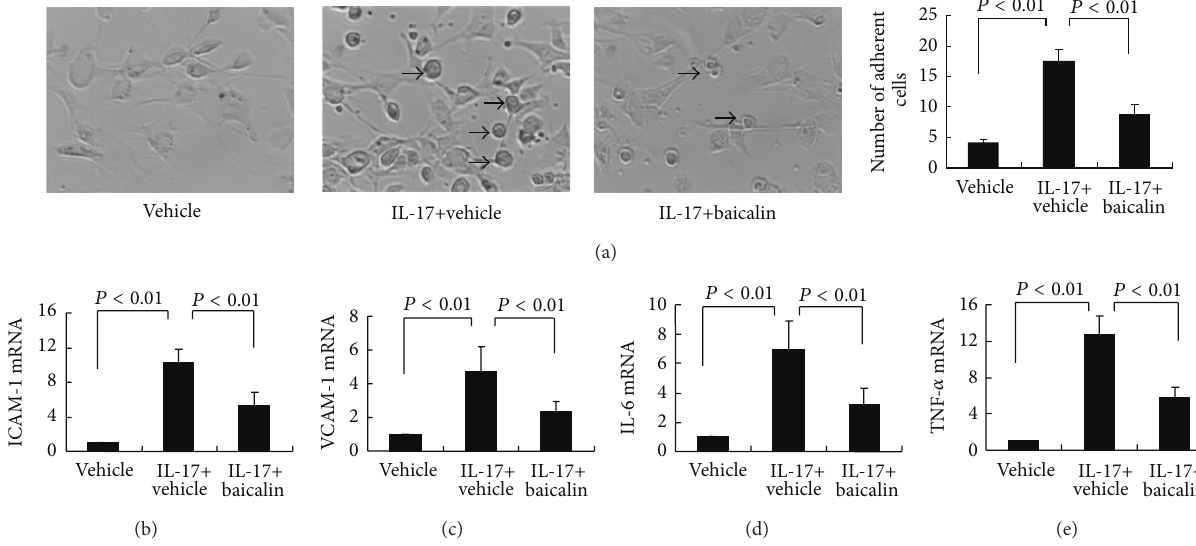
Figure 4: Baicalin inhibits IL-17-mediated inflammation reactions in vitro . (a) Synoviocytes (10,000 cells/well) were plated in 12-well tissue culture plates, allowed to adhere, and were then stimulated with 50ng/mL IL-17 with or without 20 𝜇 M Baicalin for 24 hours. Following IL- 17/Baicalinstimulation,isolatedsplenocytes(50,000cells/well)wereaddedtothesynoviocytemonolayersforanother24hours.Afterwashing twice, splenocyte adherence to synoviocytes was enumerated by microscopy at 200x magnification. Arrows indicate adhesive splenocytes (left). The number of adherent splenocytes is shown on the right. These experiments were performed three times with similar results. In mRNA expression studies, synoviocytes were cultured with 50 ng/mL IL-17 in the presence or absence 20 𝜇 M Baicalin for 24 hours, and gene expression levels of ICAM-1 (b), VCAM-1 (c), IL-6 (d), and TNF- 𝛼 (e) were examined by real-time RT-PCR. These experiments were performed three times with similar